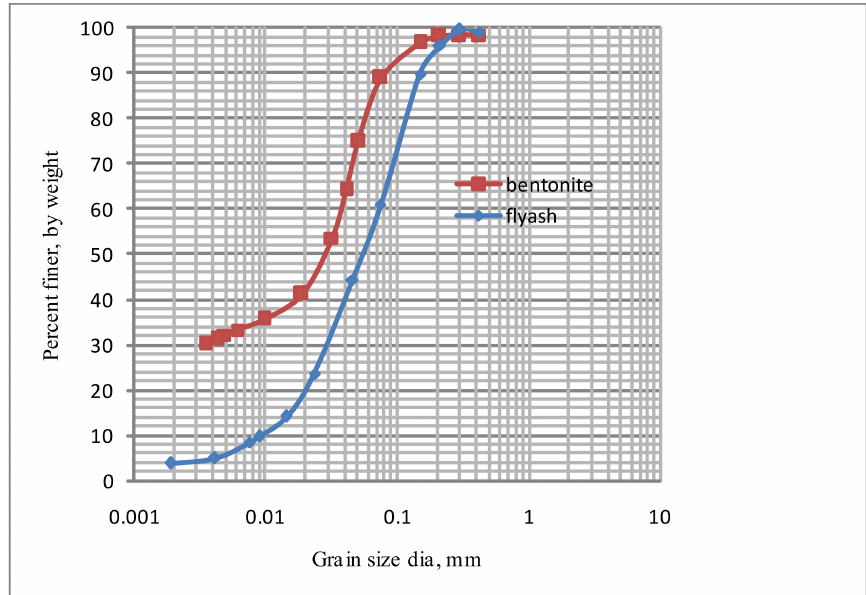
Figure 4. Particle size distribution curves for fly ash and bentonite.